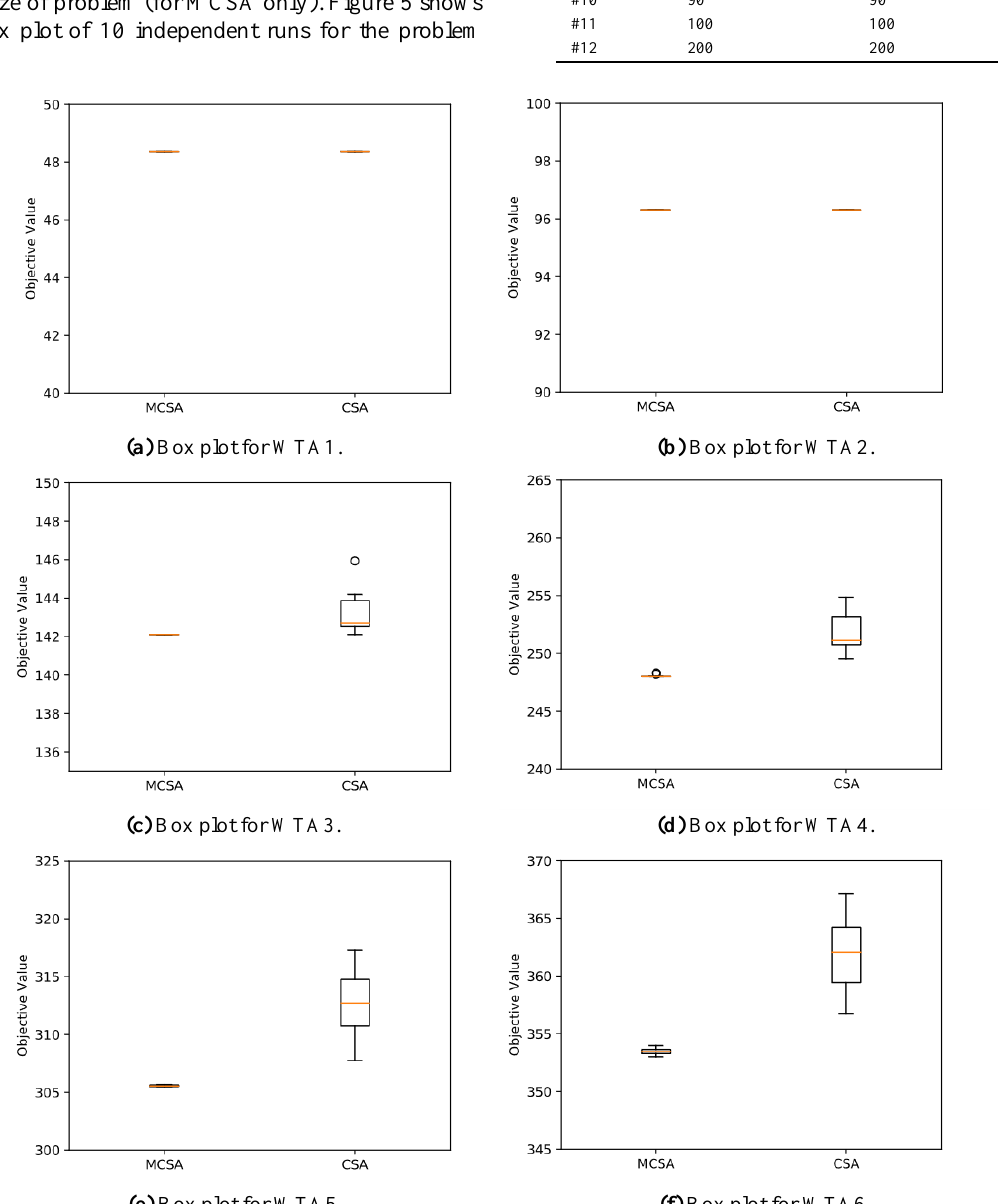
Figure 5. Box plots for comparing 10-runs results of MCSA and CSA on problem